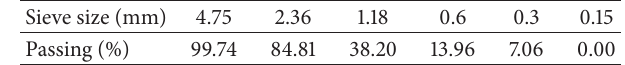
Table 2: Particle-size distribution of